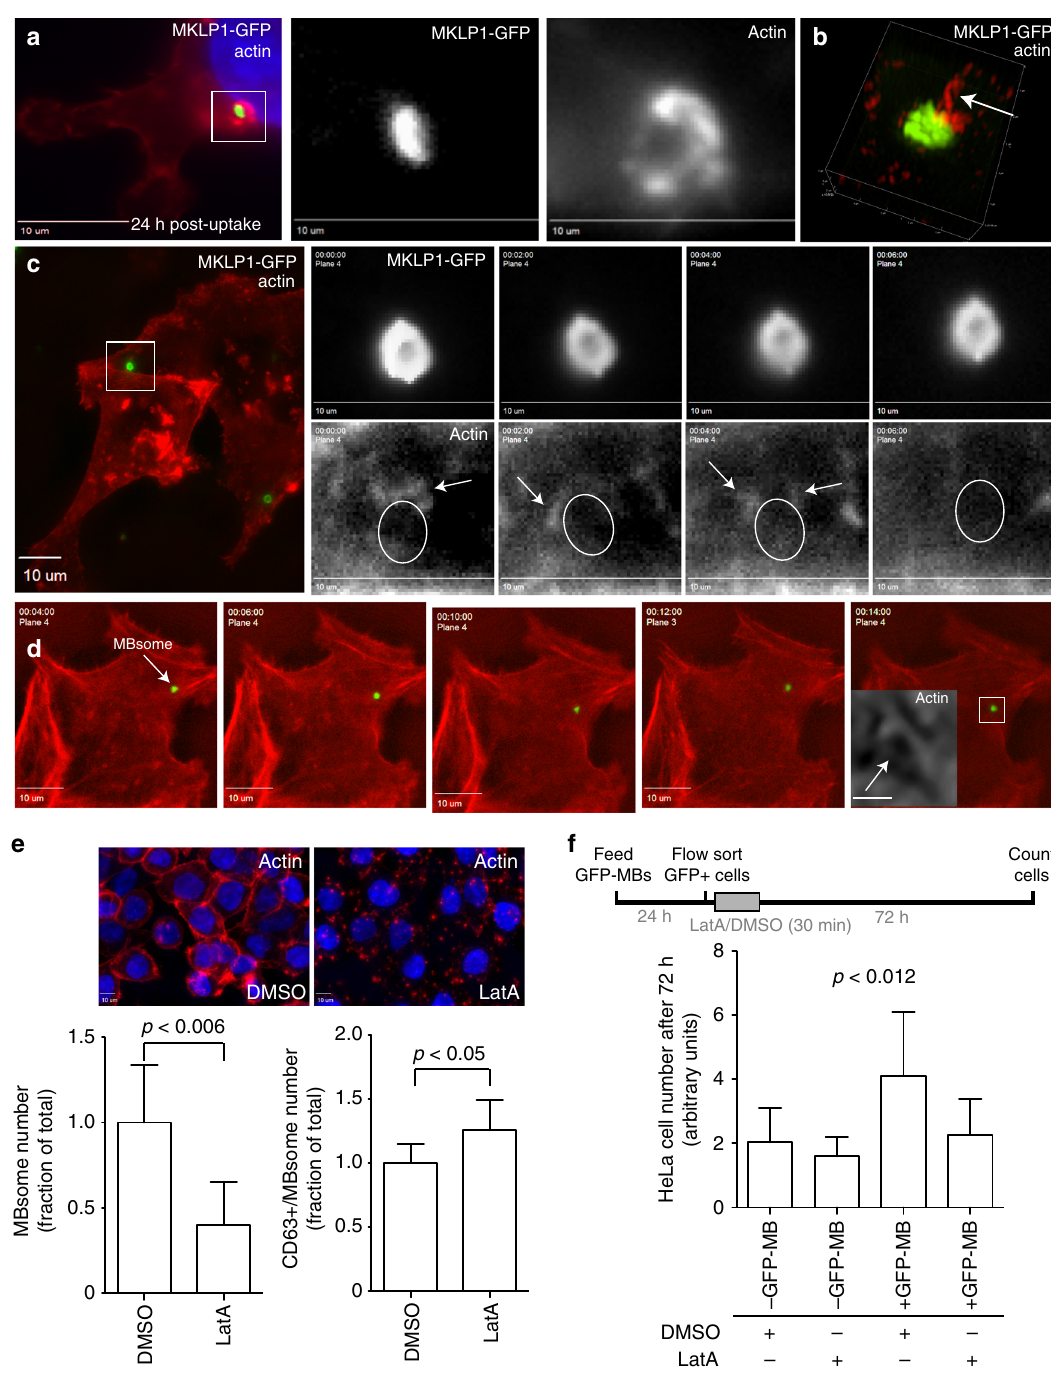
Fig. 6 MBsome-associated actin coats inhibit MBsome degradation. a , b HeLa cells were incubated with puri fi ed GFP-MBs for 3 h. Cells were then washed and incubated for another 24 h, followed by fi xation and staining with Alexa568-phalloidin. Cells were then imaged using either a regular epi fl uorescence microscope ( a ) or a SIM super-resolution microscope ( b ). Arrow in b points to MBsome associated actin patch. c , d Cells expressing mCherry-LifeAct were incubated with puri fi ed GFP-MBs. Cells were then washed and incubated for another 24 h. The dynamics of MBsome associated actin ( c ) or intracellular mobility of the MBsome ( d ) was analyzed by time-lapse microscopy. Arrows in c points to MBsome associated actin. Arrows in d point to MBsomes. Box in d marks the part of the image that was used for the inset at the last time-point of time-lapse series. Scale bar in box d is equivalent to 1 μ m. e HeLa cells were fl ow sorted for the presence of internalized GFP-MBs 24h post feeding. Cells were then treated with either DMSO or Latrunculin A for 30 min, followed by washing and incubation for another 8 h. Cells were then fi xed and analyzed for the presence of MBsomes (left bar graph) and for CD63 + MBsomes (right graph). Data shown are the means and standard deviations derived from fi ve independent experiments (Student ’ s unpaired, two-tailed t - test). f HeLa cells were fl ow sorted for the presence of internalized GFP-MBs 24 h post feeding. Cells were then treated with either DMSO or Latrunculin